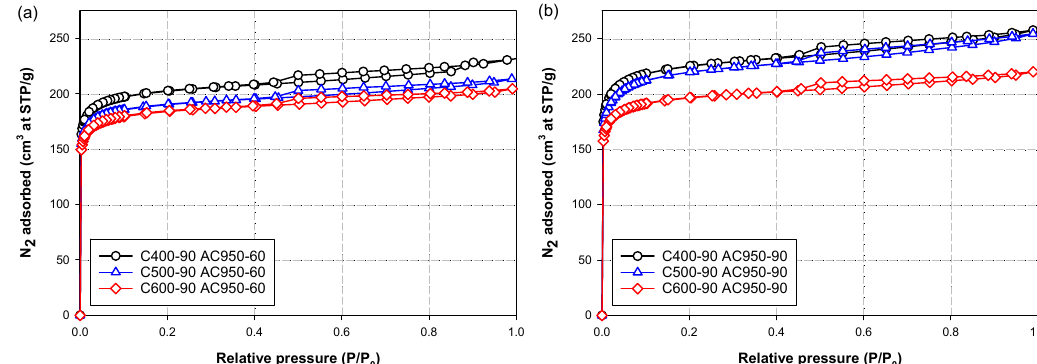
Figure 2. Effects of carbonization temperature and activation time on N 2 adsorption isotherms of activated carbon prepared by CO 2 activation at ( a ) 950 °C and 60 min ( b ) 950 °C and 90 min .